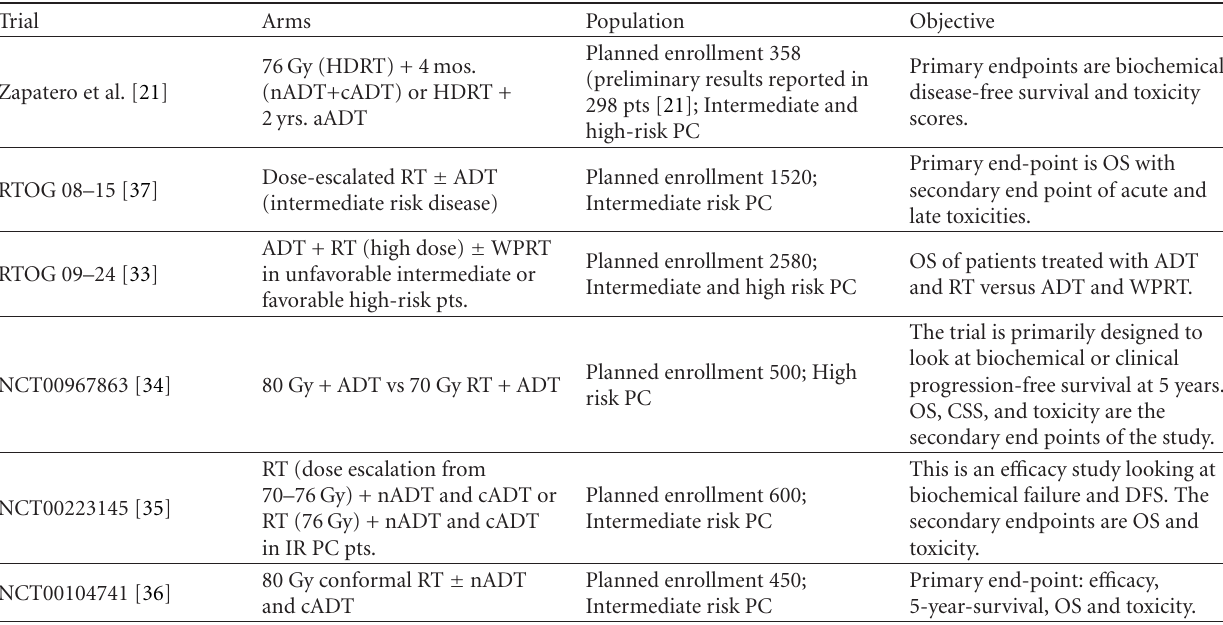
Table 2: Current